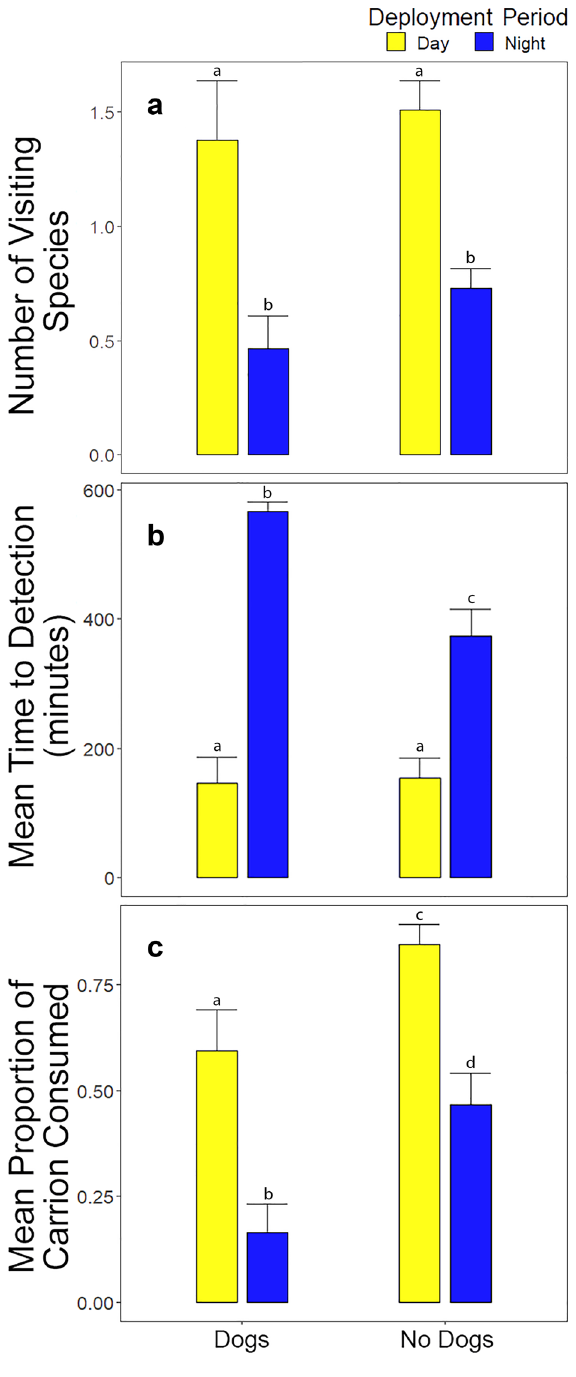
Figure 3. Differences in ( a ) mean number of visiting species; ( b ) time to first detection of carrion; and ( c ) proportion of carrion consumed at each camera location during diurnal (yellow) and nocturnal (blue) deployments (N = 63 deployments for each time period) and at sites with and without owned dogs. The height of the bar indicates the mean and the error bars represent the standard error for each